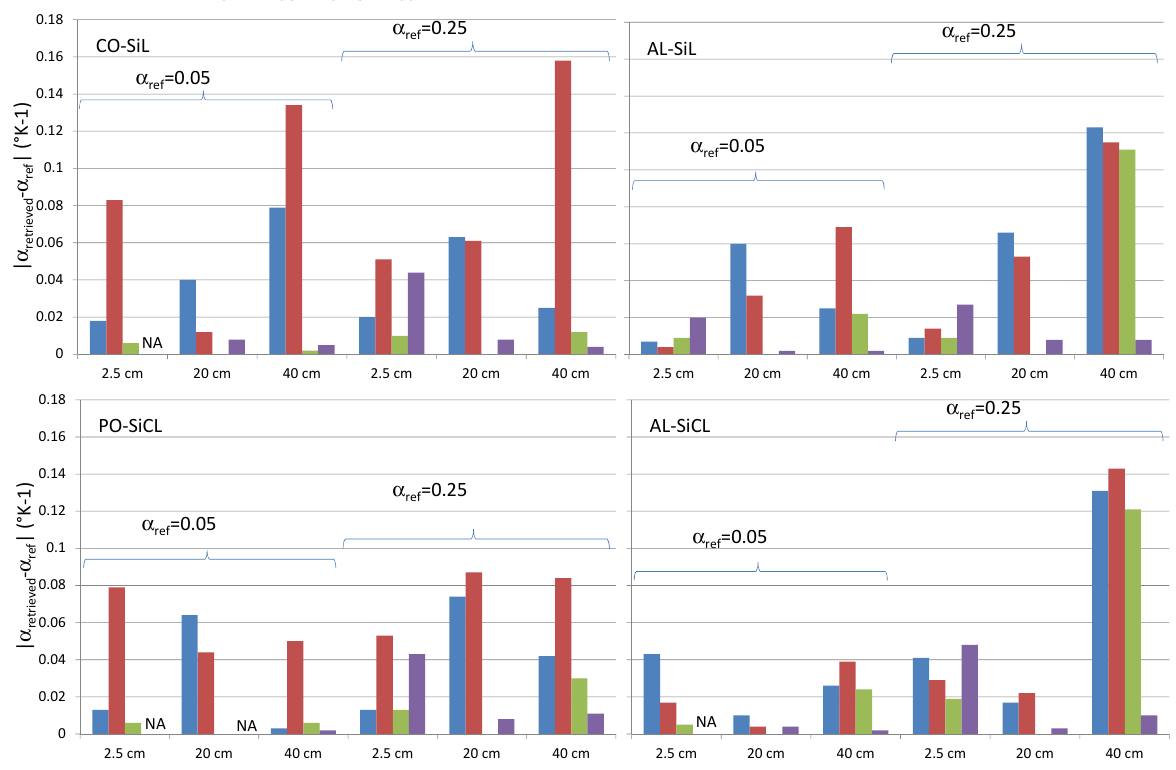
Figure 4. Absolute difference between the retrieved α (K − 1 ) at several depths (2.5, 20 and ) determined from the data simulated by the TEC model 40 cm) and the reference α ( α ref using the four methods (Cm, Ce, Cme, Cd). Each graph corresponds to a given soil. NA is given when α could not be determined. SiL and SiCL correspond to soils having a Silt Loam and Silty Clay Loam texture,